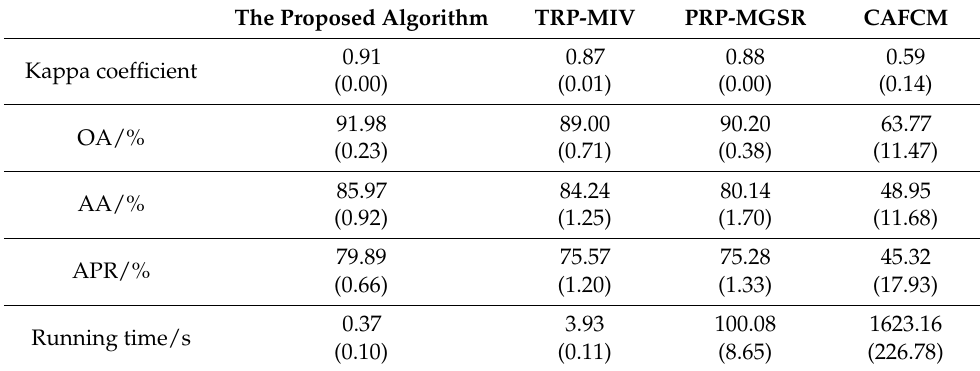
Table 4. Accuracy evaluation of classification results for the Salinas image. (The values in brackets are the variance of 100 trials, and those not in are the